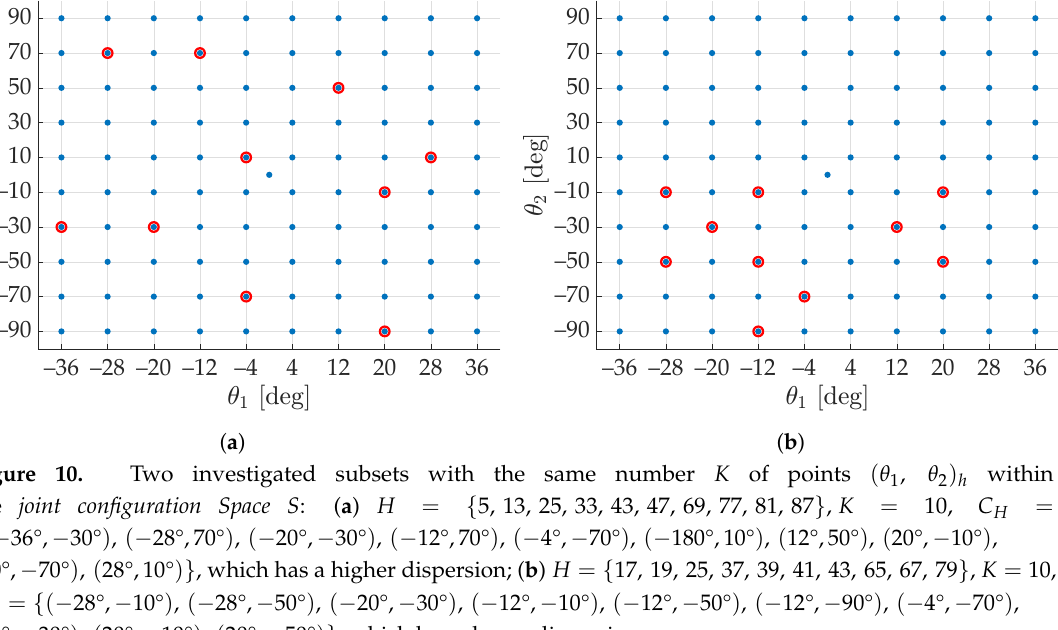
Figure 10. Two investigated subsets with the same number K of points ( θ 1 , θ 2 ) h within the joint configuration Space S :